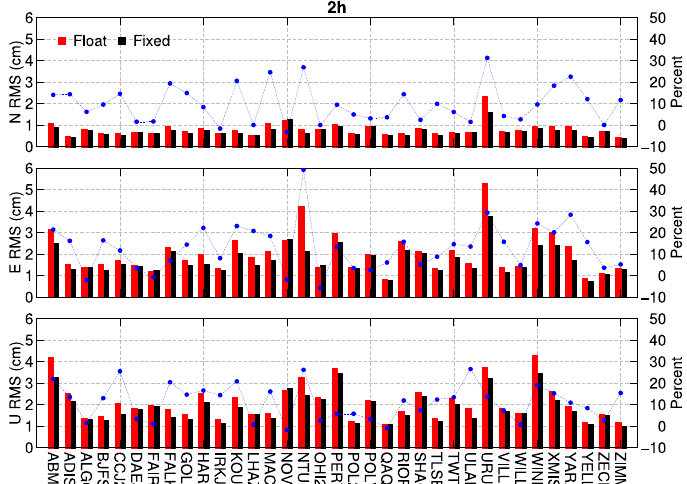
Figure 11. RMS of the float and fixed position estimates for 2 h hourly data length with respect to the weekly estimates for 35 stations during 7days.